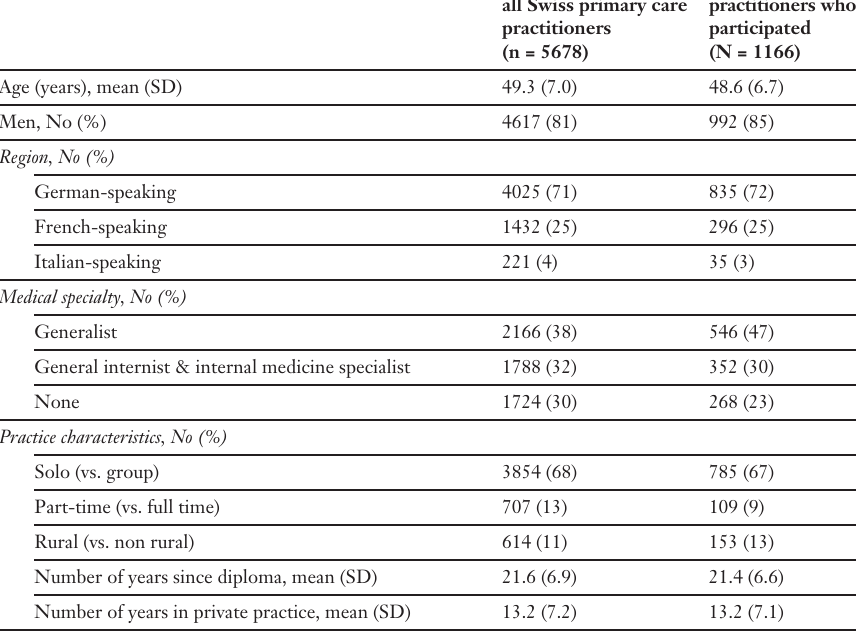
Characteristics of survey participants compared to those of all non-paediatric pri- mary care practition- ers registered with the Swiss Medical